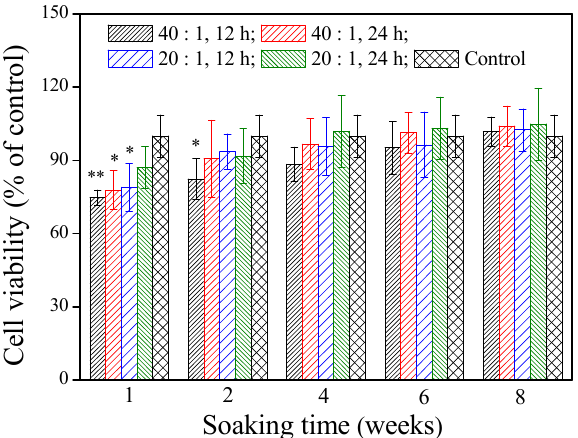
Figure 4. The effect of the γ –PGA/ β –TCP composite fiber extract on the MG-63 cell viability by a MTT assay after 2 days of culture. The results are expressed as a percentage of the control (* p < 0.05 and ** p < 0.01 vs. control).